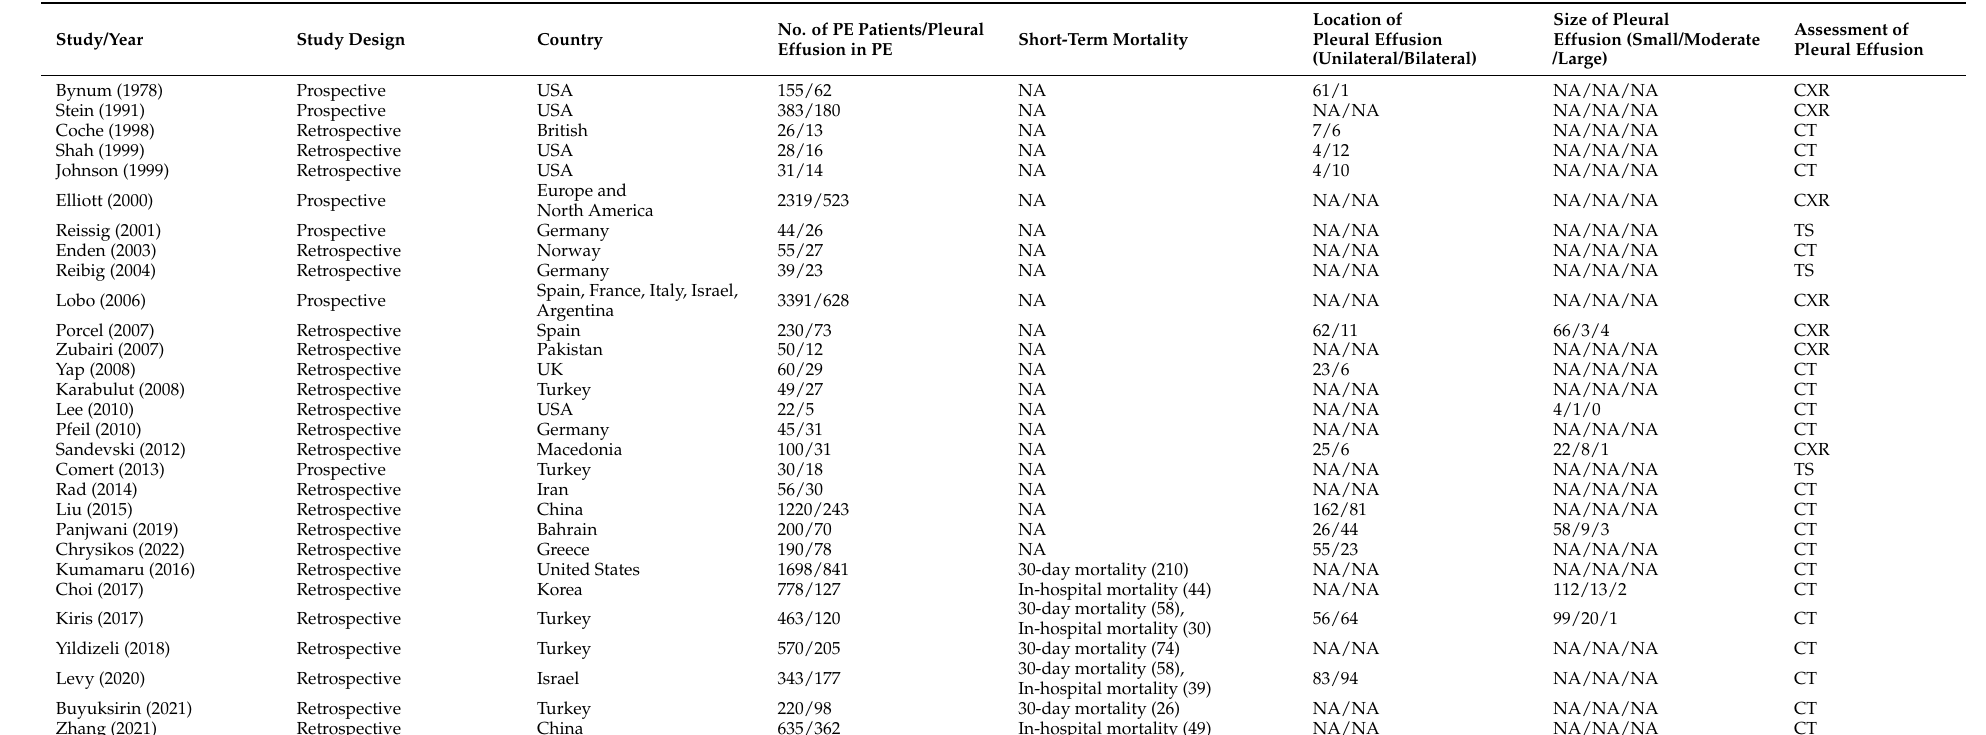
Table 1. Characteristics of included